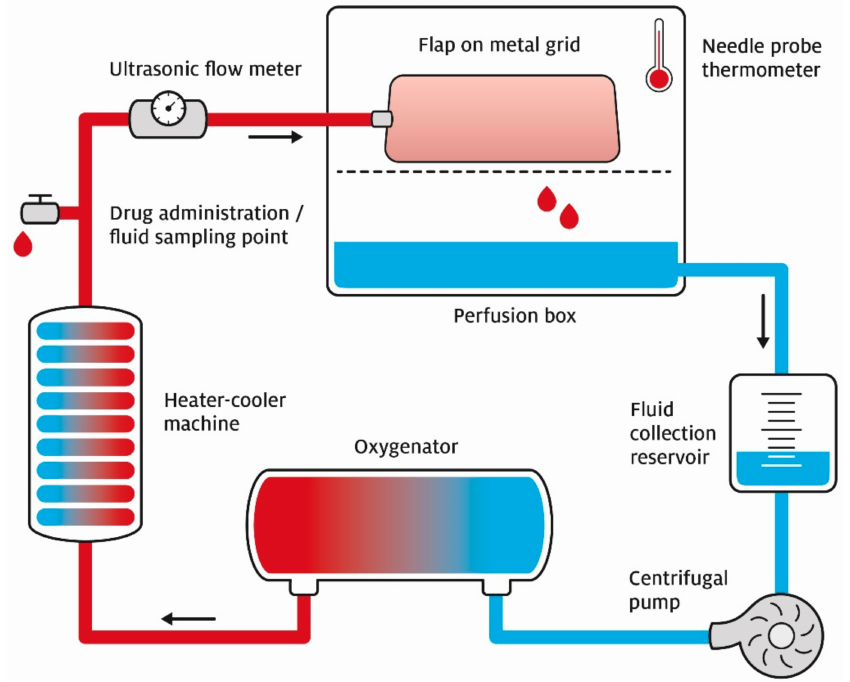
Figure 1. Schematic illustration of the extracorporeal perfusion set-up. The semi-closed perfusion set- up (closable box) with a flap in the perfusion box on top of a metal grid. This allows passive venous drainage of the preservation fluid into the collection reservoir. The centrifugal pump is pressure regulated at in-line ≤ 30 mmHg and the fluid is infused with a mix of 95% O 2 and 5% CO 2 in the oxygenator. The heater–cooler machine cools the fluid to 8–10 ◦ C. There is a drug administration point and fluid sampling point. Before entering the flap via the artery, the ultrasonic flow meter measures flow per minute.